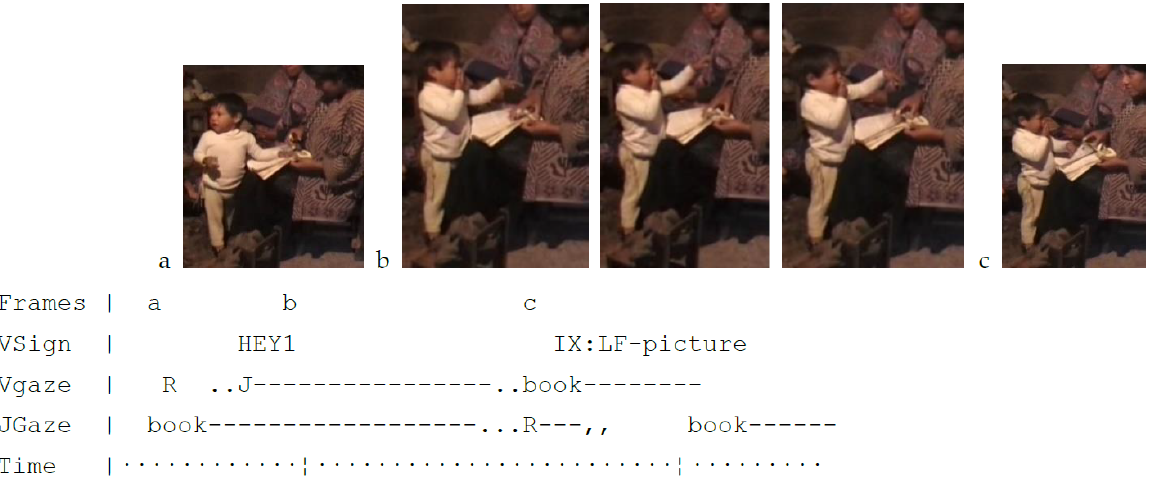
Figure 20. Vic at 24 mos. was told “ask your mom what it’s called”. ( a ) Vic looked away from his cousin as she spoke to him, turned to his mother, who was looking down at the book, raised his left hand so that it passed through her line of sight, and ( b ) did a quick HEY1 with downward flip of the fingers, before ( c ) touching the chosen picture on the page.